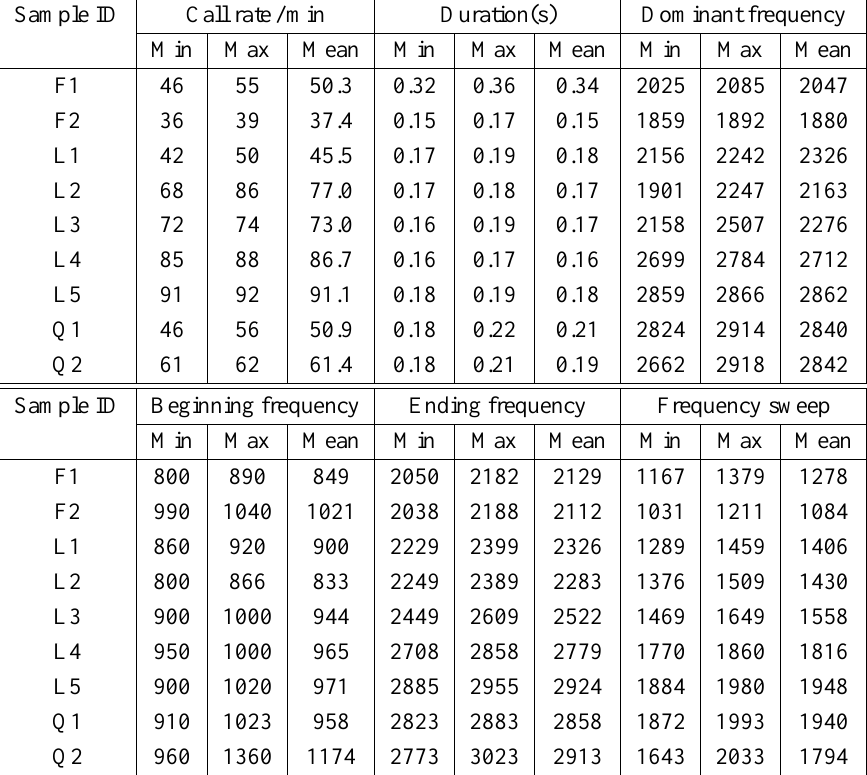
Summary data for multiple recordings from single localities. All variables except for beginning frequency standardized to 25 o C. Sample IDs are those used in multidimen- sional scaling analysis 1